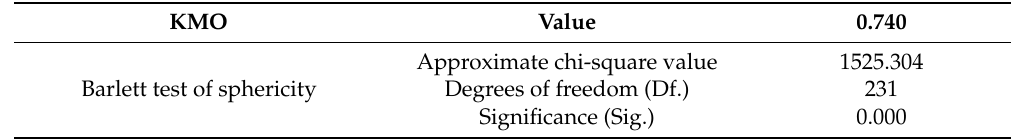
Table 1. KMO and Barlett test of sphericity.